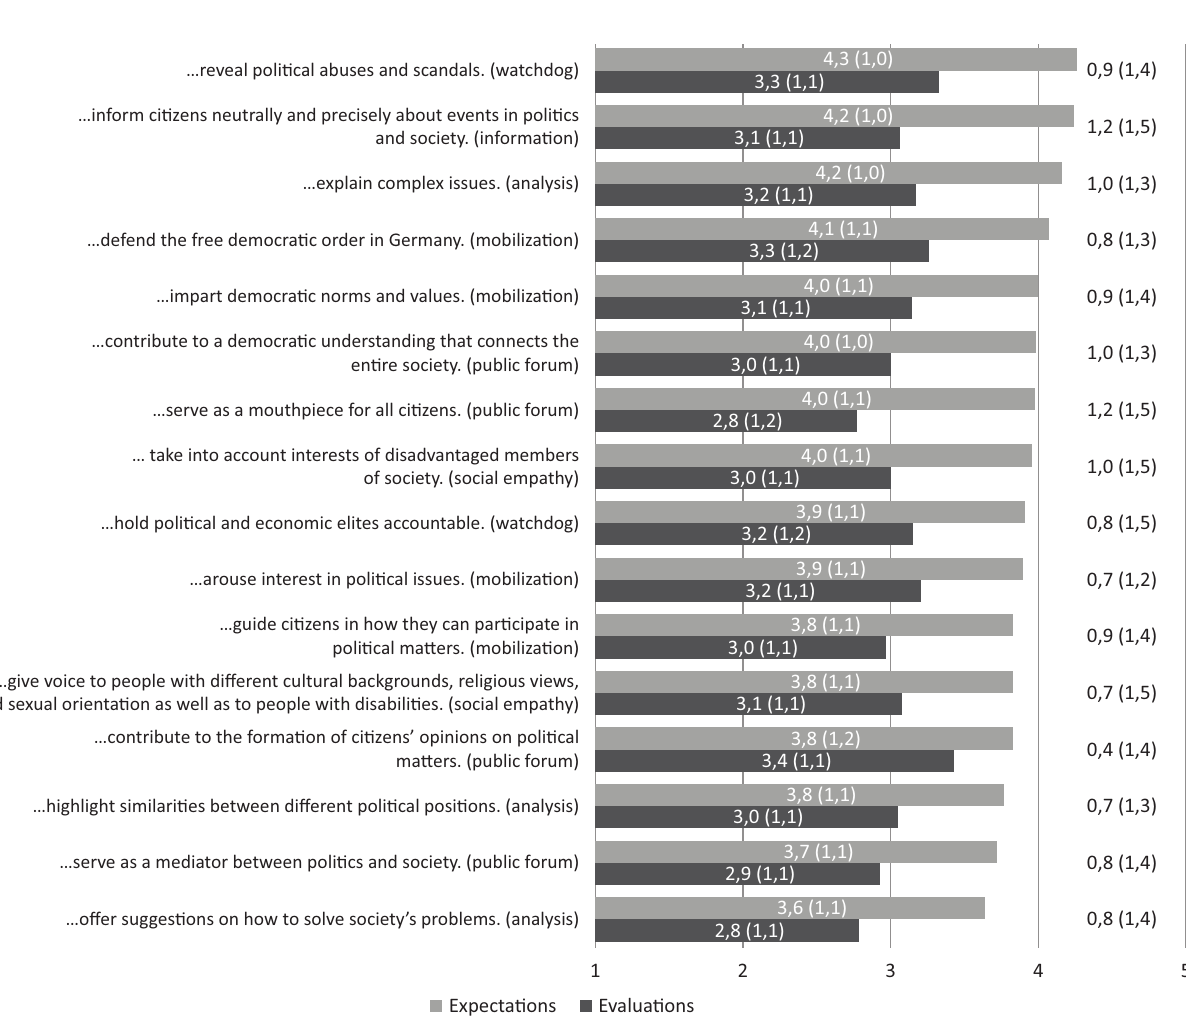
Figure 1. Citizens’ expectations and evaluations of media performance in comparison. Notes: Mean values with SD in parentheses; light grey values represent mean expectation–evaluation discrepancies ( SD in parentheses); 862 ≤ n ≤